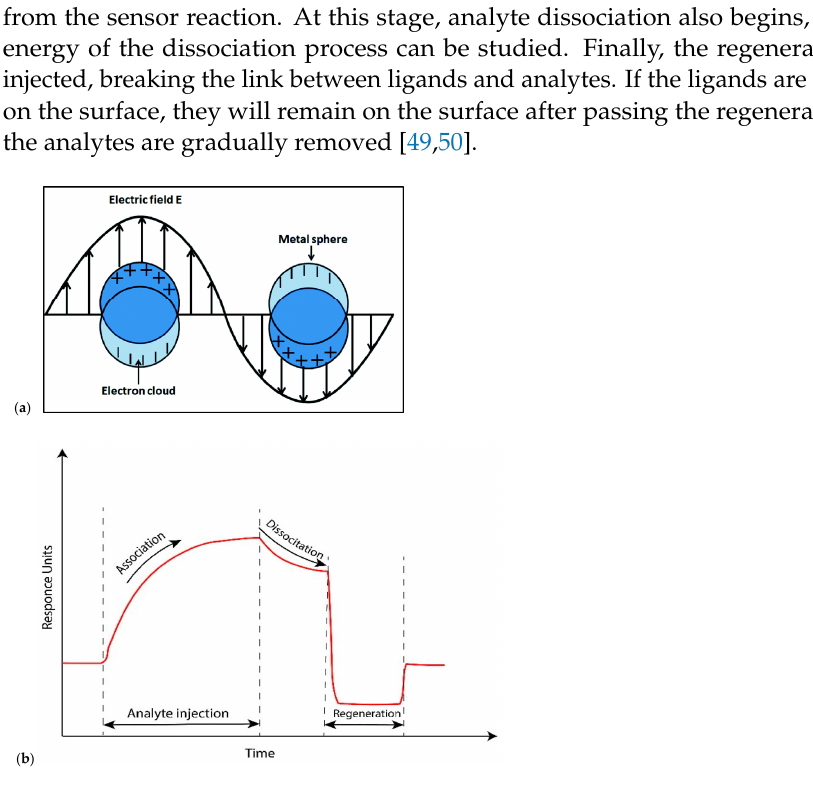
Figure 1. ( a ) Schematic of the surface plasmon (electronic cloud) resonated due to the electric field. (Reprinted with permission [51]. Copyright © 2016, The Author(s). Licensee: IntechOpen.) ( b )